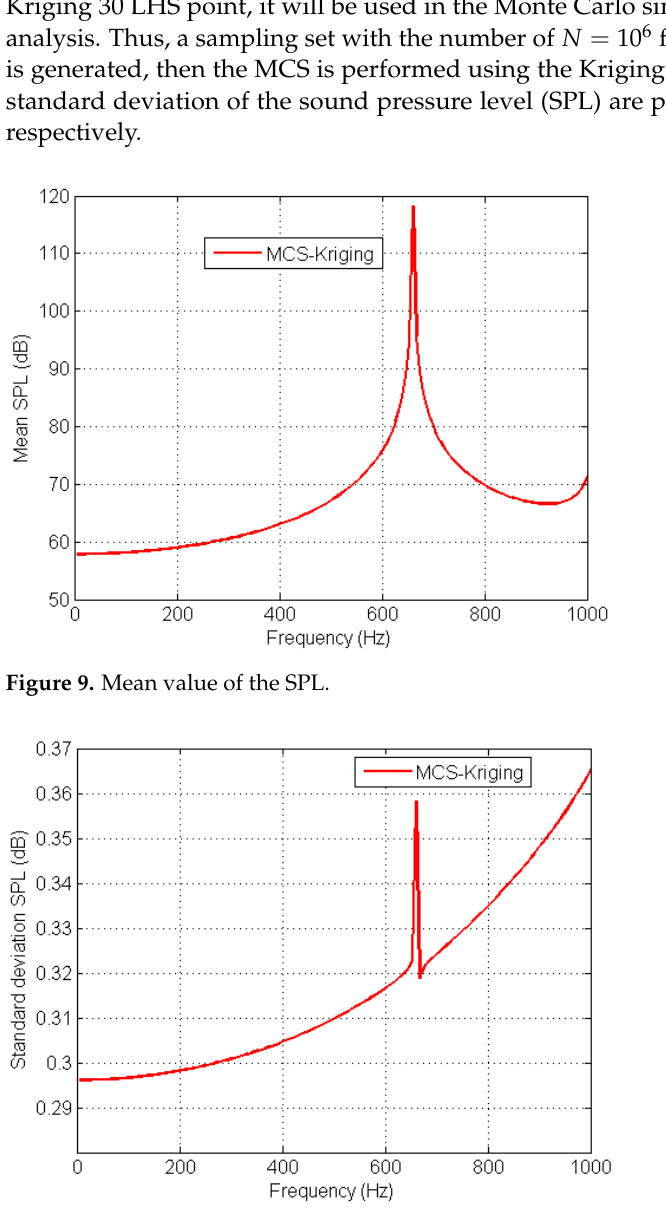
Figure 10. Standard deviation value of the